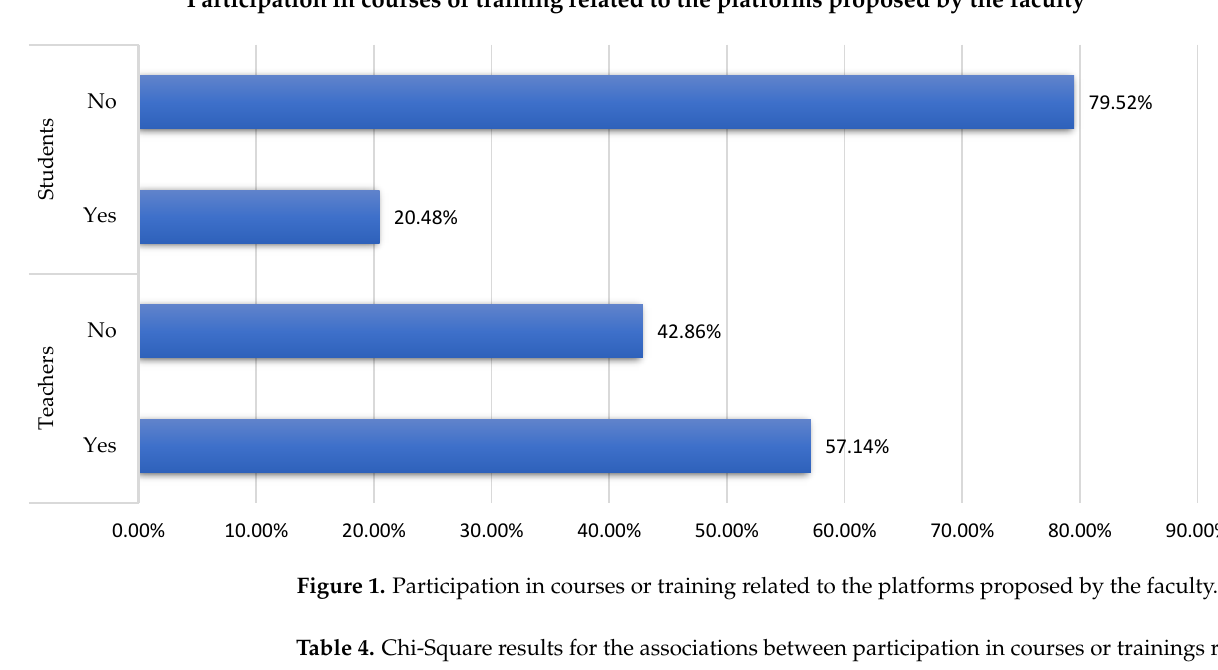
Table 3. Participation in courses or trainings related to the use of online platforms depending on the level of English language proficiency.